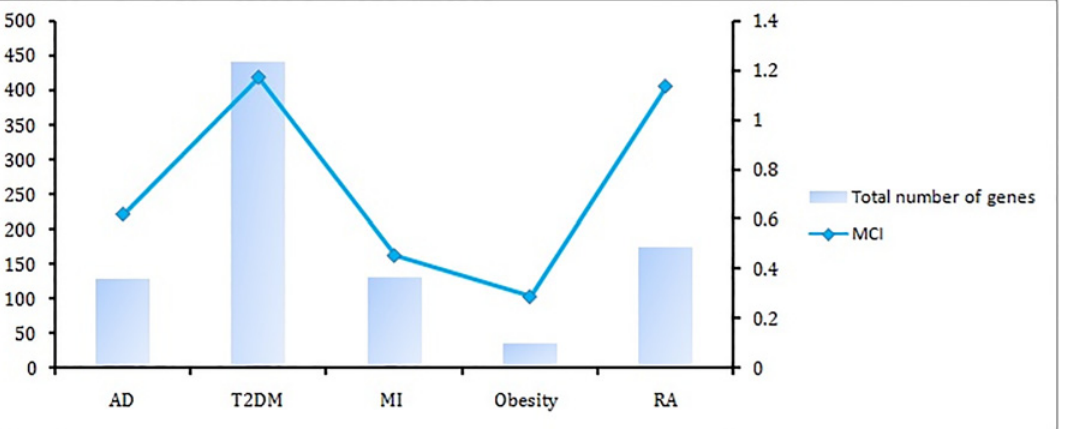
Fig 7. Molecular comorbidity index (MCI). Number of proteins shared between psoriasis and its comorbidities. MCI shows the strength of association between psoriasis and its comorbidities. The association becomes stronger with the increasing number of shared genes and high MCI.